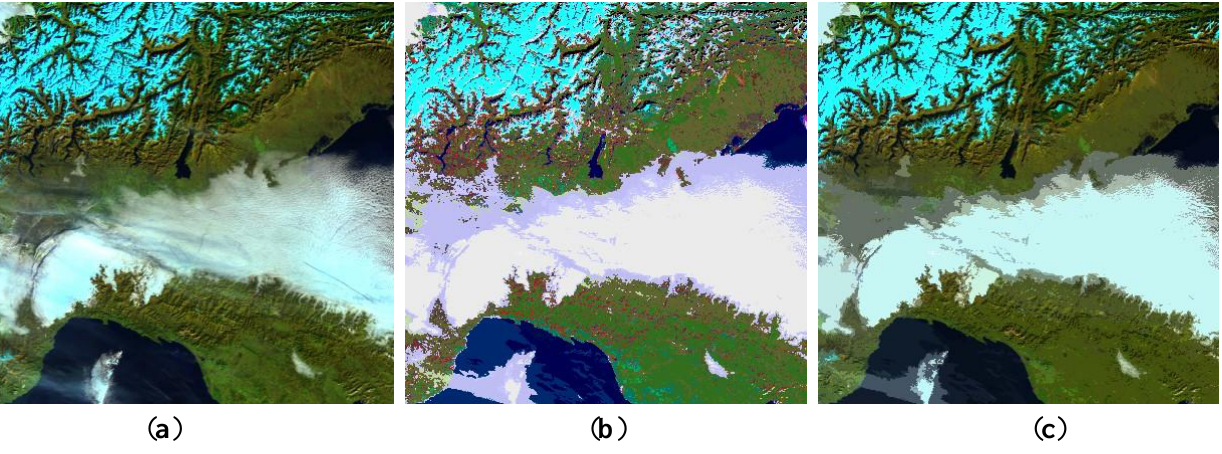
Figure 5. ( a ) Transect extracted from the MODIS Band 2 (NIR) of Figure 4(a). ( b ) Transect extracted from the L-SIAM™ preliminary classification map featuring 95 spectral categories, indexed from 1 to 95, and shown in Figure 4(b). ( c ) Transect extracted from Band 2 (NIR) of the piecewise constant approximation of the 7-band MODIS input image shown in Figure 4(c). In comparison with the original transect shown in (a), small but genuine image details appear well preserved. In practice, L-SIAM™